Question: What does this figure show? Answer in one sentence.
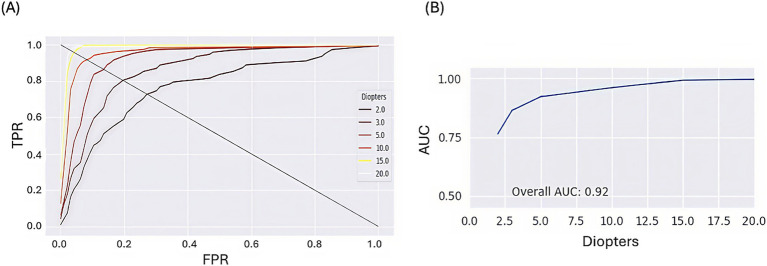
Answer: ROC analysis for detection of induced skew versus no induced skew based on trial setup; (A) x -axis represents the FPR (proportion of no skew detection trials classified as skew) and y -axis represents the TPR (proportion of skew detection trials correctly classified); (B) improved detection performance as prism diopters increases; ROC, receiver operating characteristic curve; AUC, area under the curve; FPR, false positive rate; TPR, true positive rate.